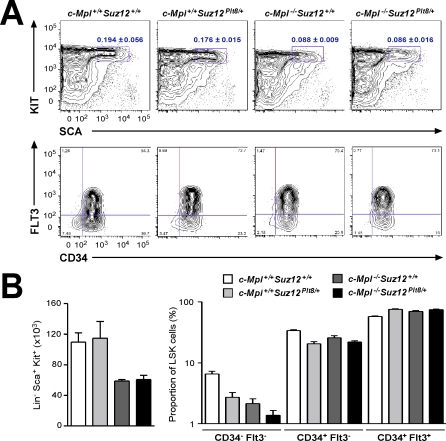
Immunophenotypic Analysis and Quantification of HSCs in Suz12Plt8/+ Mice(A) The representation of LSK cells was assessed in whole bone marrow from Suz12Plt8/+ mice and wild-type littermates. The percentage shown represents the mean (± standard deviation) of 4–7 mice of each genotype. Analysis of LT- and ST-HSCs was performed on lineage-depleted bone marrow.(B) The absolute number of LSK cells present in four leg bones (two femurs and two fibulas) was determined. The proportion of CD34– Flt3–, CD34+ Flt3– and CD34+ Flt3+ cells is shown for the LSK population, data represent the mean (± standard error) of 4–12 mice of each genotype.